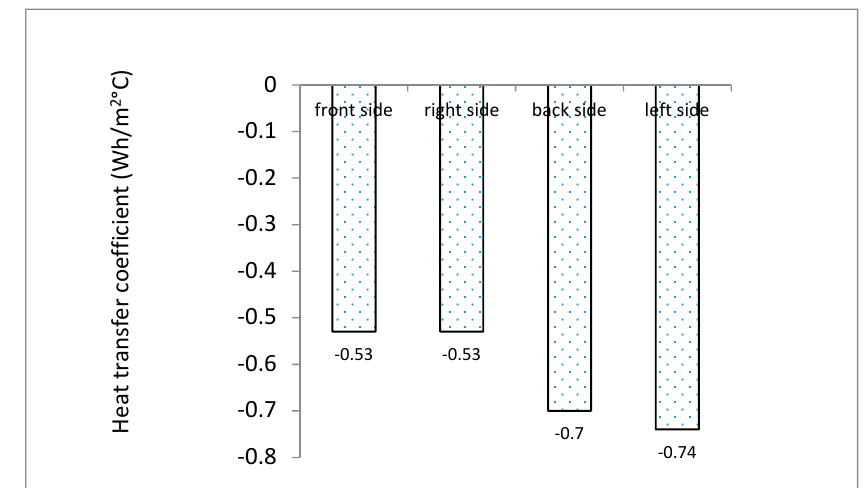
Figure 9. Heat gain/loss owing to indirect solar.